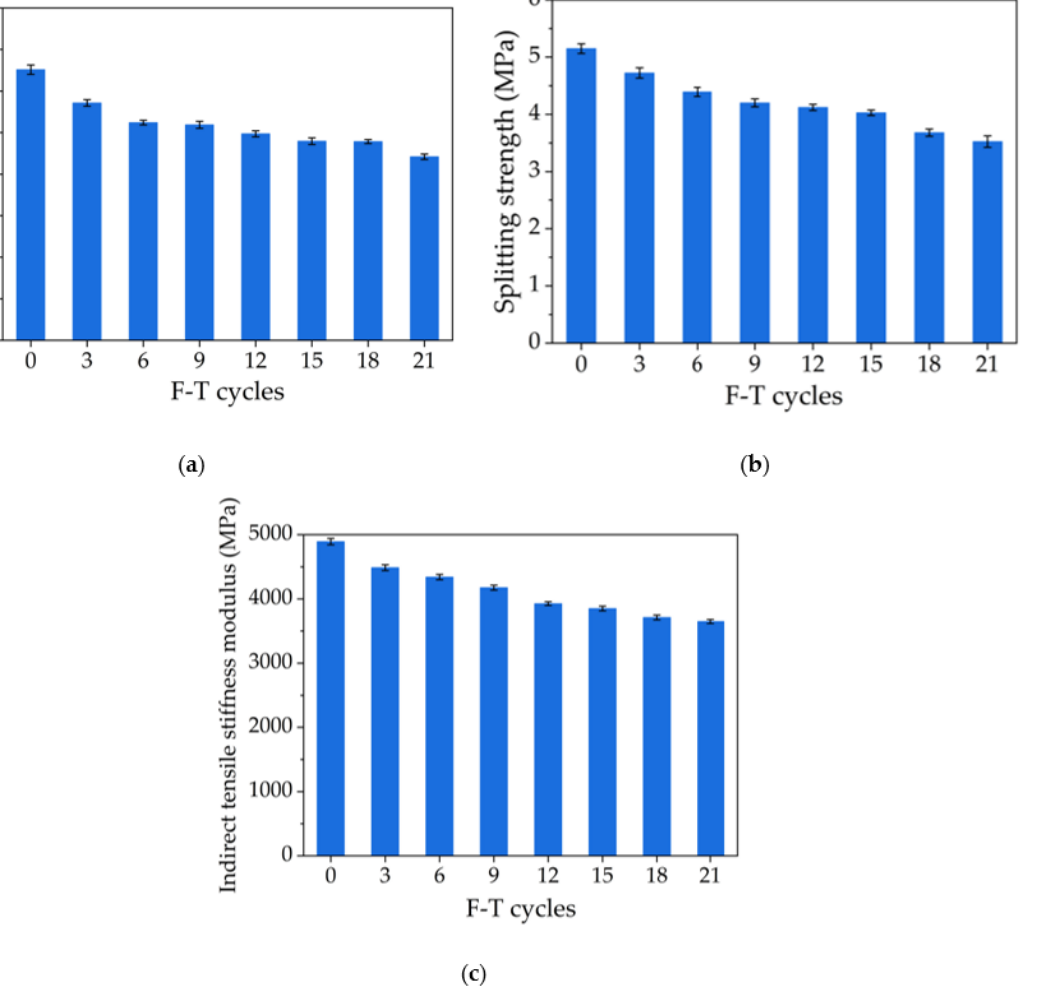
Figure 5. The macro mechanical properties results: ( a ) Compression strength, ( b ) Splitting strength, ( c ) Indirect tensile stiffness